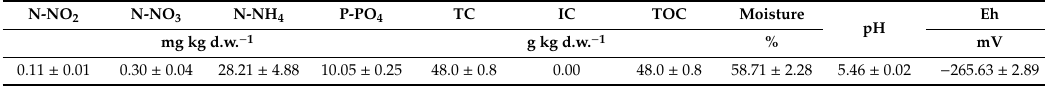
Table 1. Characteristics of investigated sediments ( ± SD).